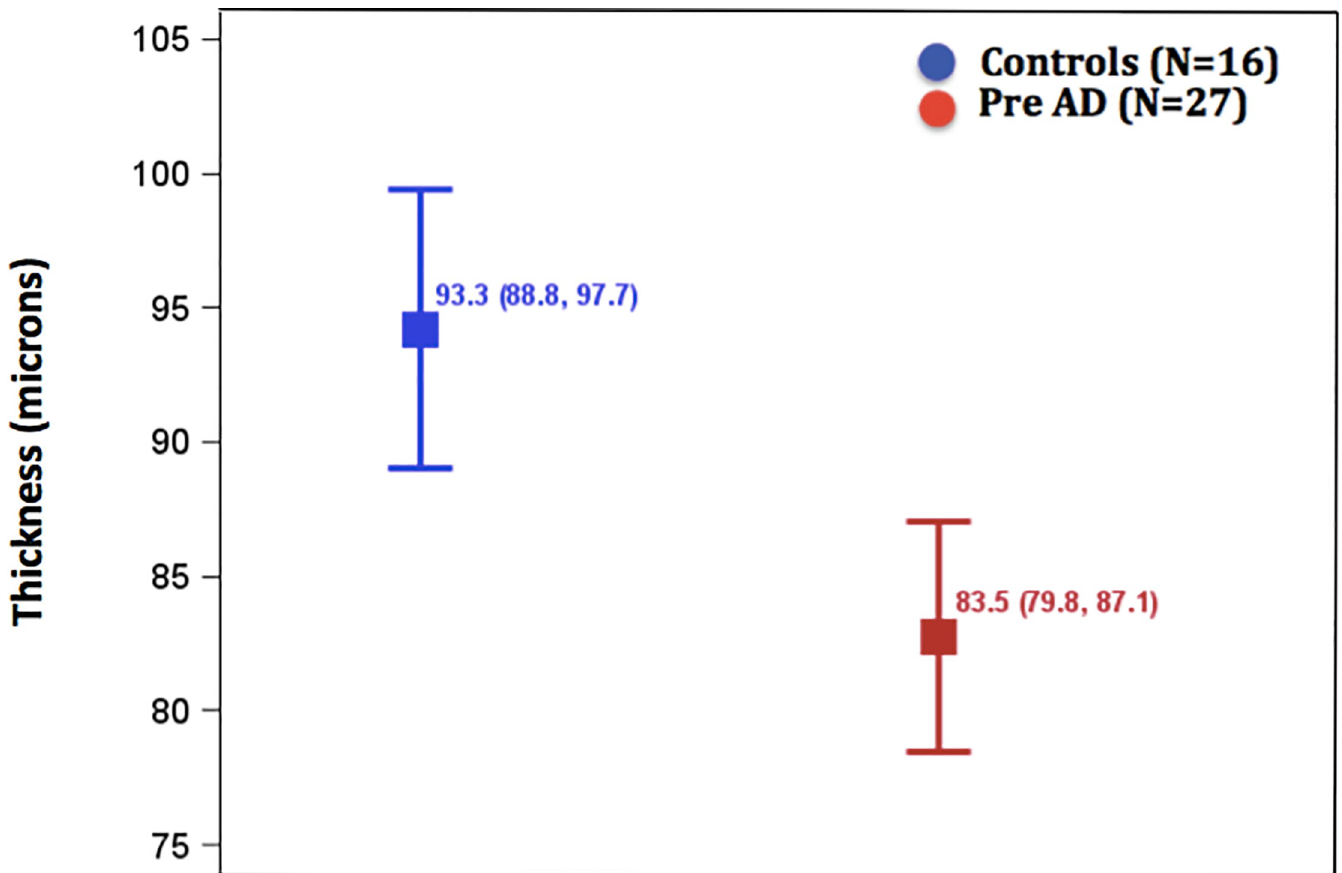
Fig 2. Depicts least-squares mean (95% CI) retinal nerve fiber layer (RNFL) thickness adjusted for side and region between cognitively healthy controls (blue) and preclinical AD participants (red).